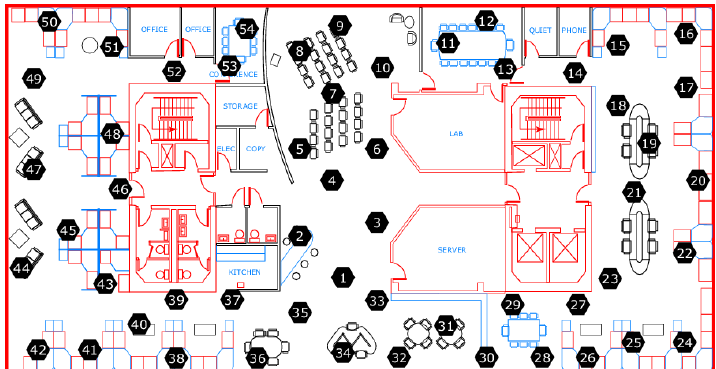
Figure 3. The venue of sensors deployment from Intel Berkeley Research Lab.